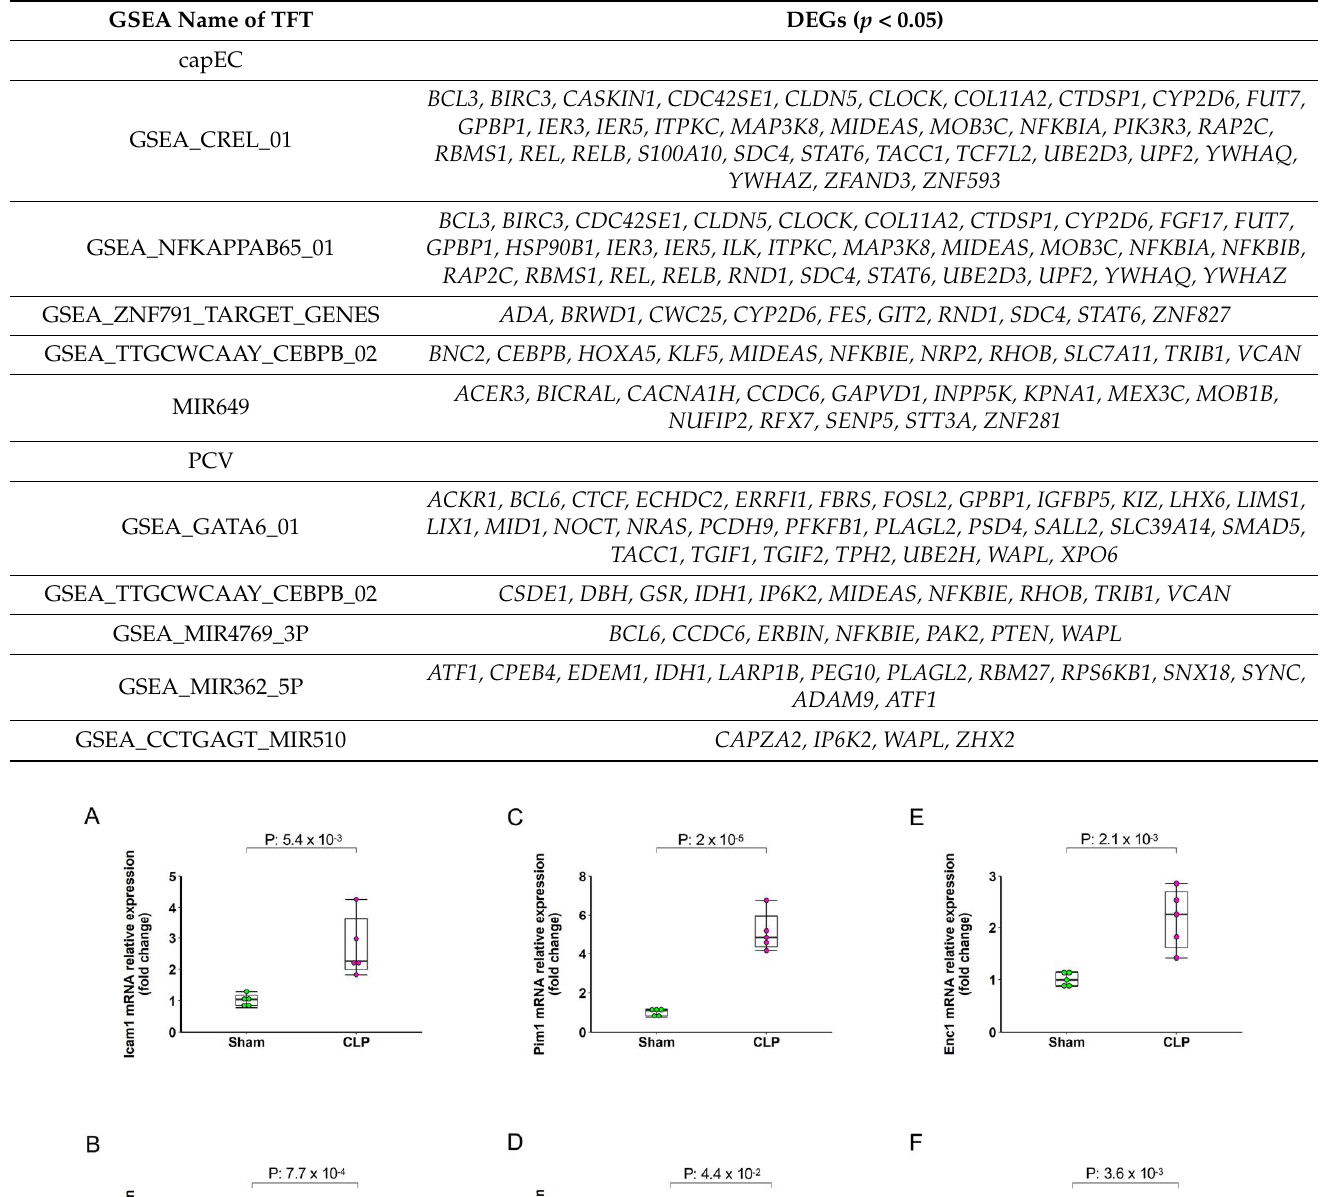
Table 3. Top 5 transcriptional factor target (TFT) gene sets in lung capEC and PCV.